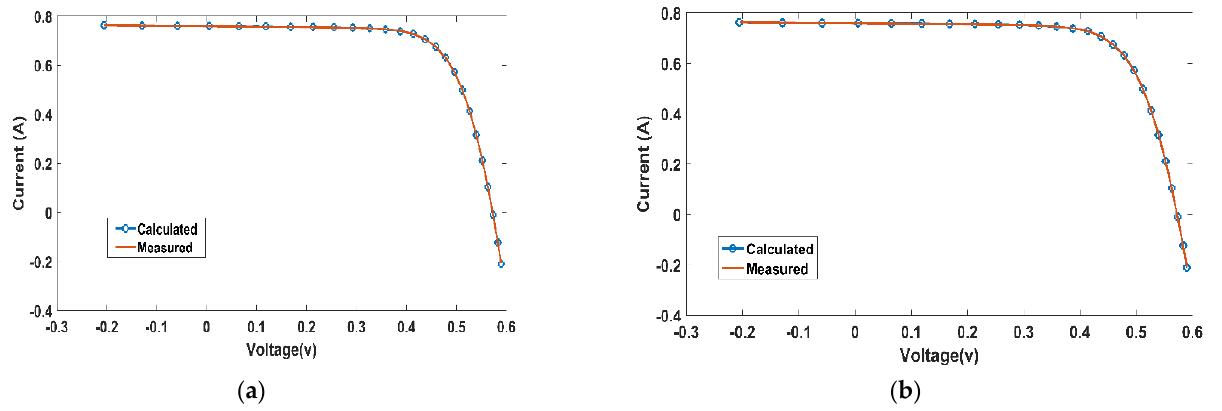
Figure 8. Measured power vs. calculated by CEHO. ( a ) single diode. ( b ) double diode.